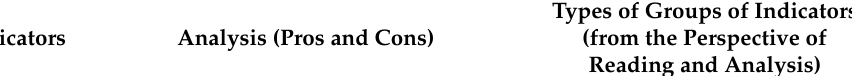
Table 2 . Groups of indicators analyzed .